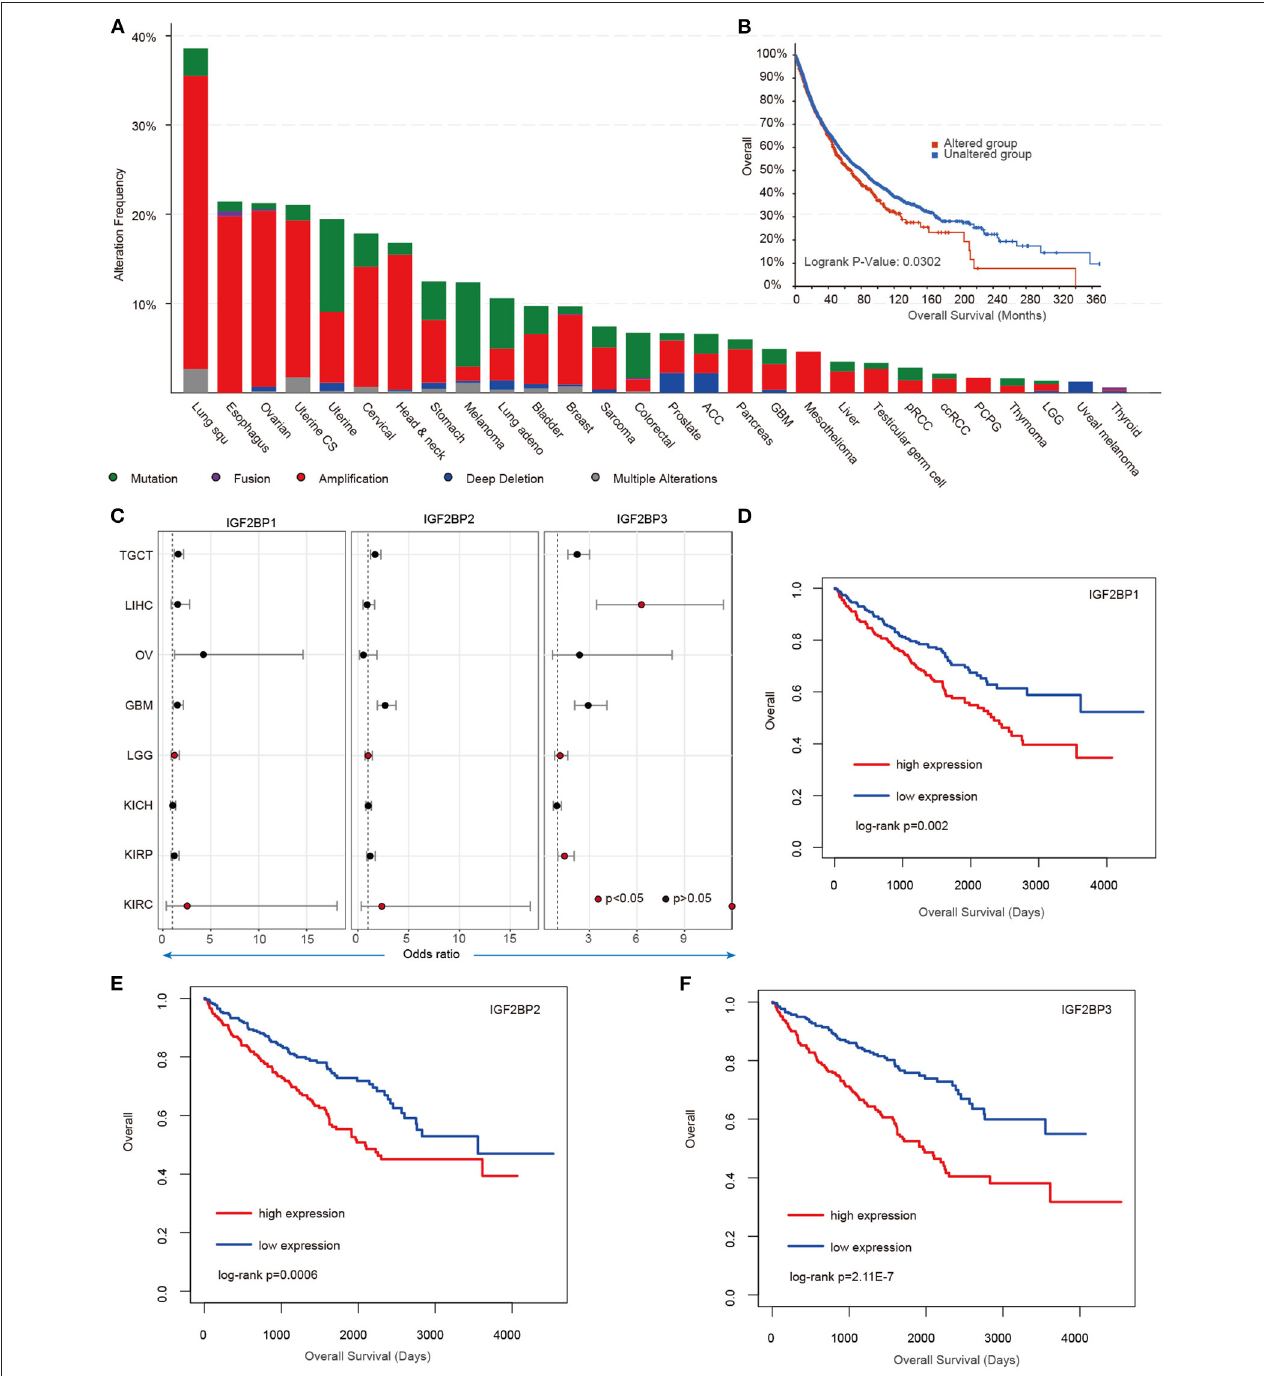
FIGURE 4 | Genetic alterations and clinical association of IGF2BPs in cancer. (A) Bar plots showing the genetic alterations of IGF2BPs across cancer types. (B) Kaplan–Meier analysis of cancer patients in the IGF2BPs altered and unaltered groups. (C) Odds ratios of IGF2BPs across cancer types. (D) Kaplan–Meier analysis of KIRC cancer patients in the IGF2BP1 high expression and low expression groups. (E) Kaplan–Meier analysis of KIRC cancer patients in the IGF2BP2 high expression and low expression groups. (F) Kaplan–Meier analysis of KIRC cancer patients in the IGF2BP3 high expression and low expression groups.